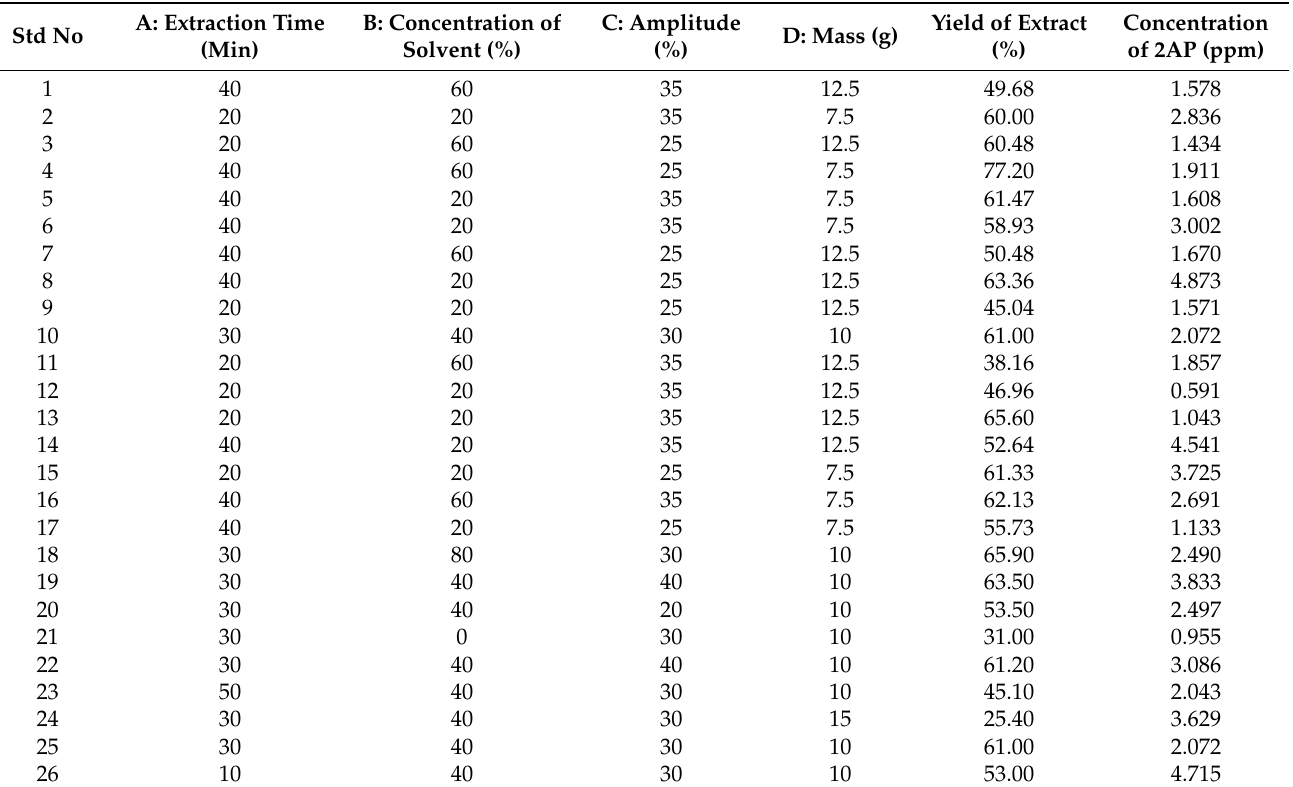
Table 2. Table of varied parameters and concentration of 2AP